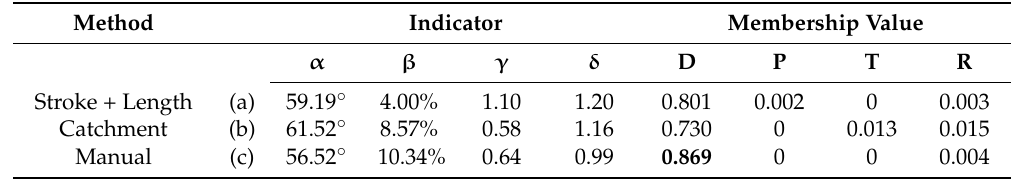
Table 4. Assessment result of generalized networks in Figure 8 where “D”, “P”, “T” and “R” stand for dendritic, parallel, trellis and rectangular patterns